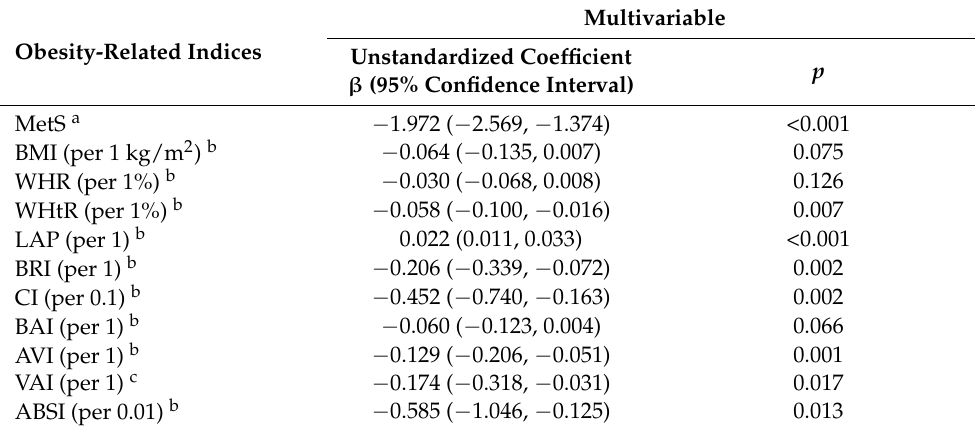
Table 6. Association of MetS and obesity-related indices with (cid:52) eGFR using multivariable linear regression analysis in follow-up participants ( n = 27,033).